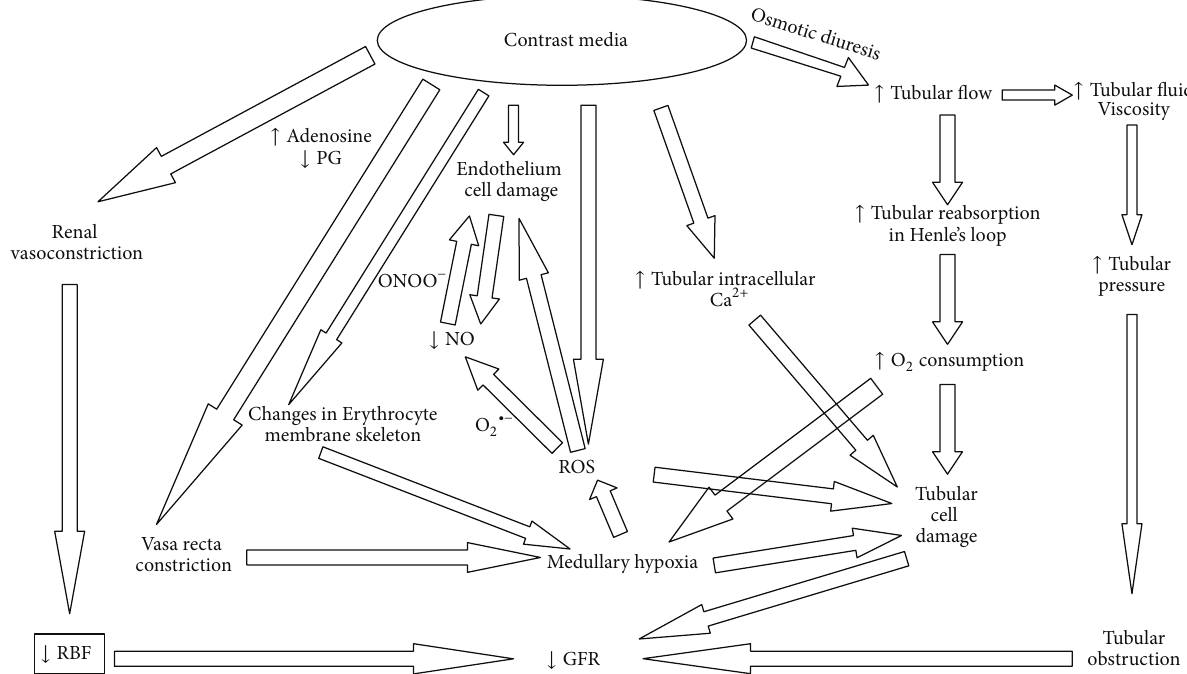
Figure 1: The complex mechanisms by which iodinated radiographic contrast media cause the fall of GFR.